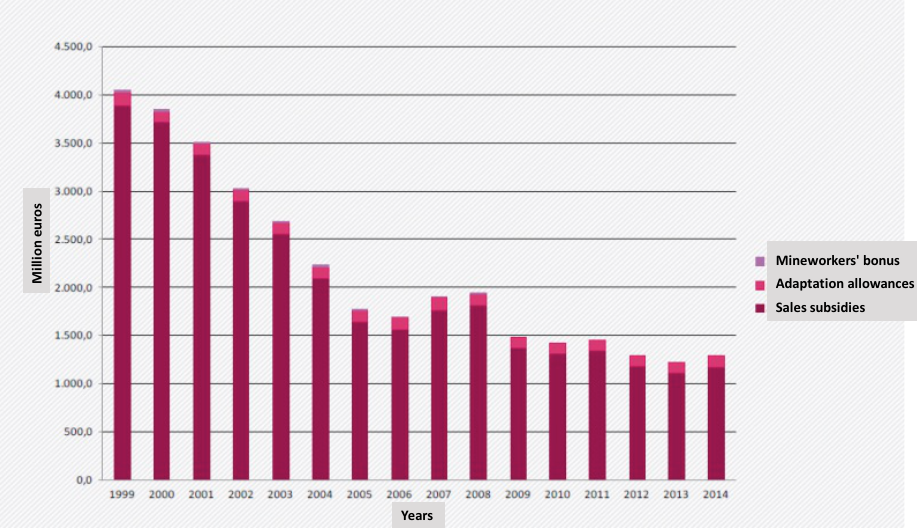
Fig. 4. Government funding for hard coal from 1999 to 2014. Source: German Federal Environment Agency (ed.) 2014,